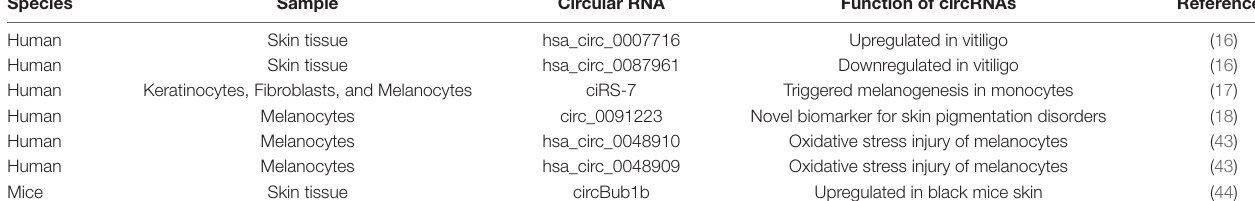
TABLE 1 | Circular RNAs (circRNAs) expression profiles in vitiligo.